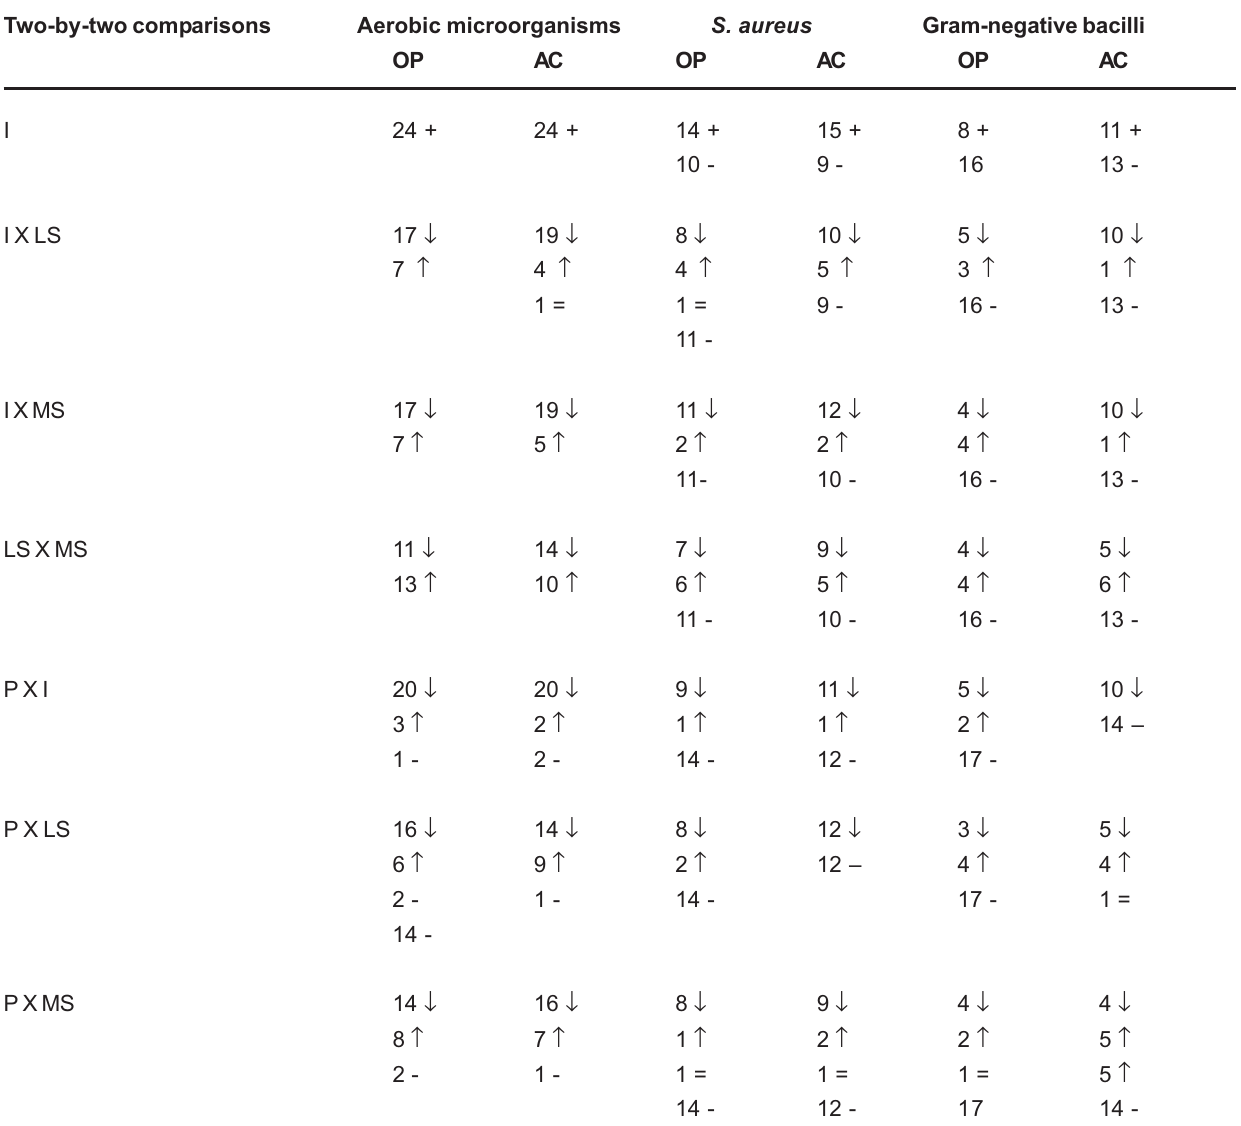
TABLE 6- Comparison of the number of cfu of aerobic microorganisms, S. aureus and gram-negative bacilli in the OP biofilm and AC before and after use of the cleansing